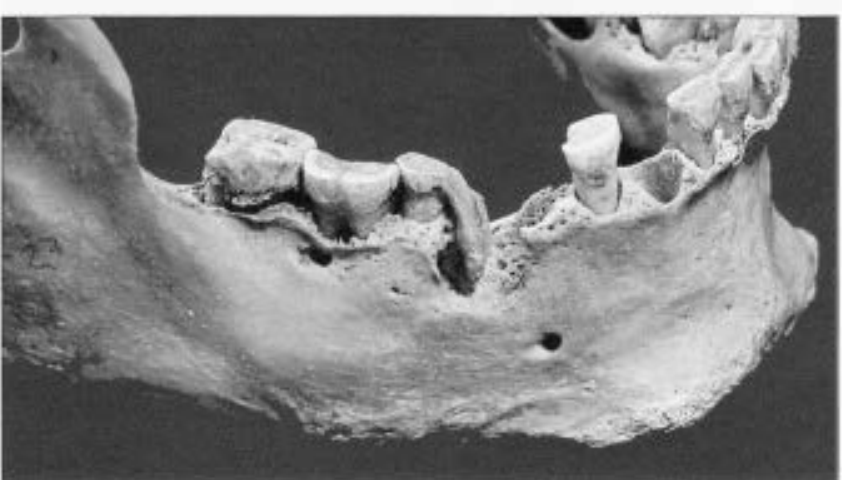
Figure 7 Another jaw from the Roca Verde site, showing very irregular